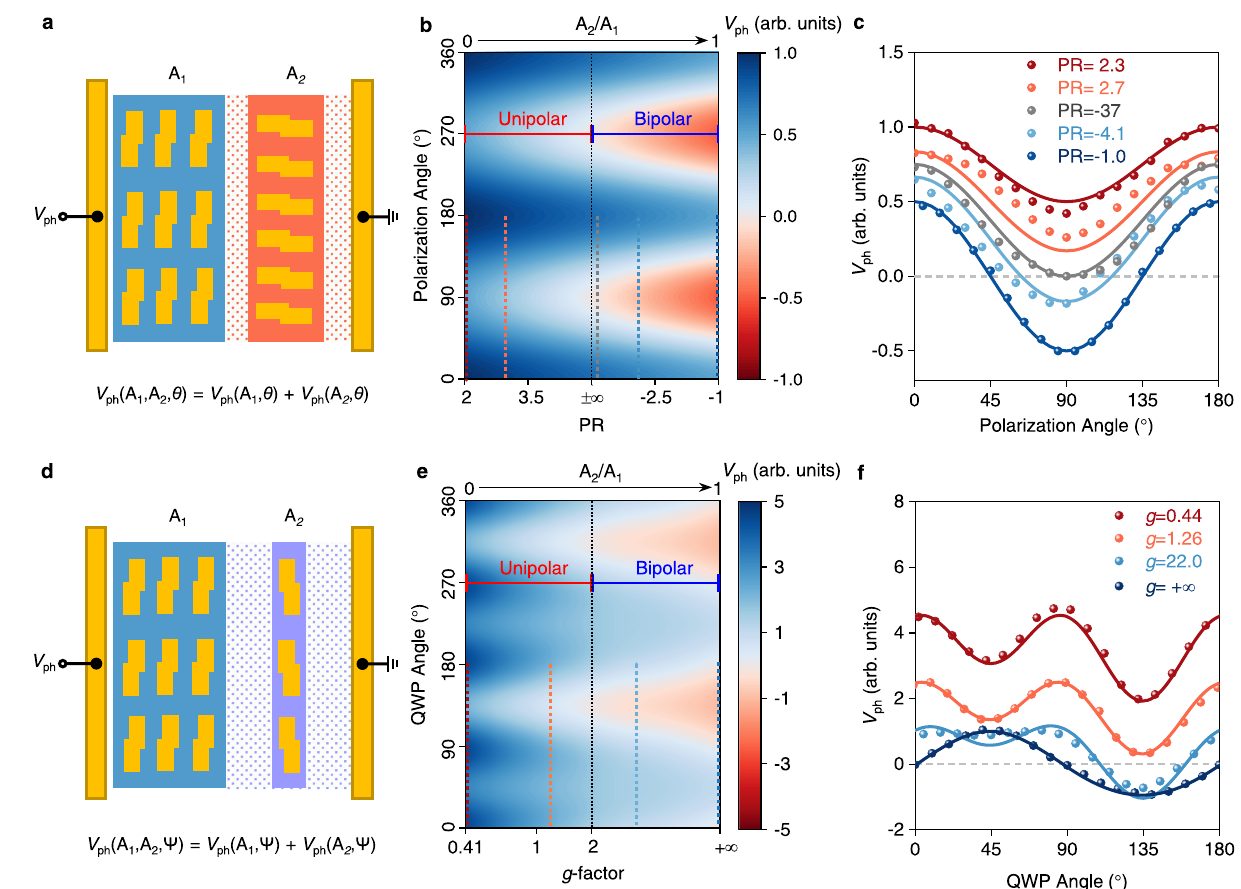
Fig. 3 | Con fi gurable polarity transition of linear and circular polarization dependence. a Calculation of the linear polarization angle θ -dependent photo- response, V ph (A 1 , A 2 , θ ) with different distribution area ratio (A 2 /A 1 ) of two nanoantennas with an orientation angles of 90°. b Calculation of the linear polar- izationangle θ -dependentphotoresponse V ph (A 1 ,A 2 , θ )withrespecttotheratioof A 2 /A 1 exhibits a polarization ratio (PR) transition from unipolar regime to bipolar regime.Thecolorbarshowsthenormalizedphotoresponse. c Simulated(lines)and measured (symbols) photoresponses of fi ve typical devices with their polarization